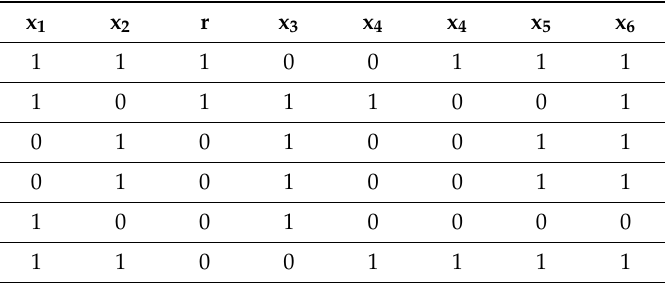
Table 1. An example of dichotomous mutation.